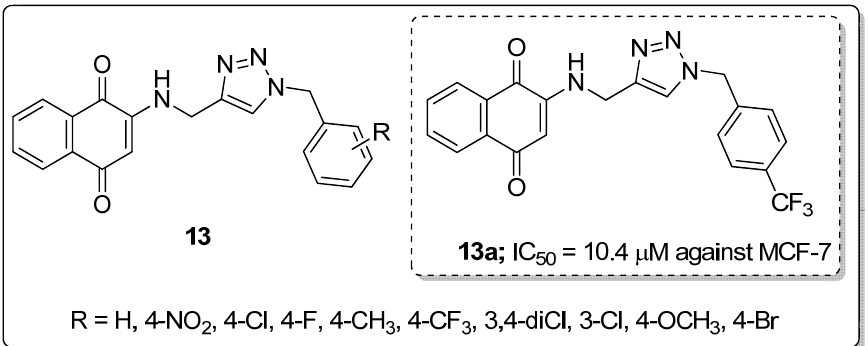
Figure 15. Cytotoxic activity of the most ‐ active naphthoquinone ‐ 1,2,3 ‐ triazole conjugate 13a .